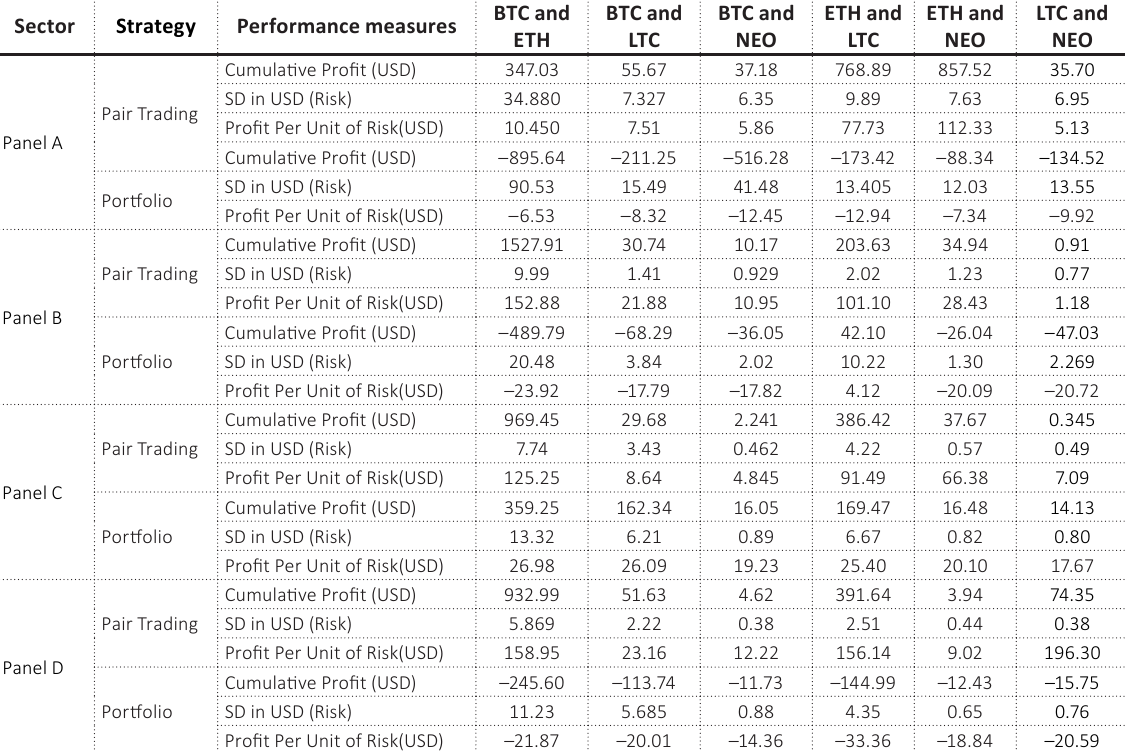
Table 6. Profit payoffs from pairs trading in simulated